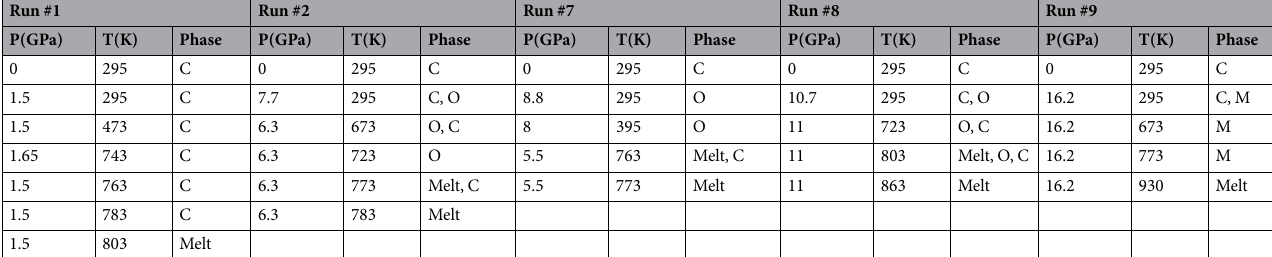
Table 1. Pressures measured during heating for individual experimental runs, with C, O and M representing cubic (fluorite), orthorhombic (cotunnite) and monoclinic (“post-cotunnite”) phases. Uncertainties in pressure and temperature are up to ± 2 GPa and ± 5